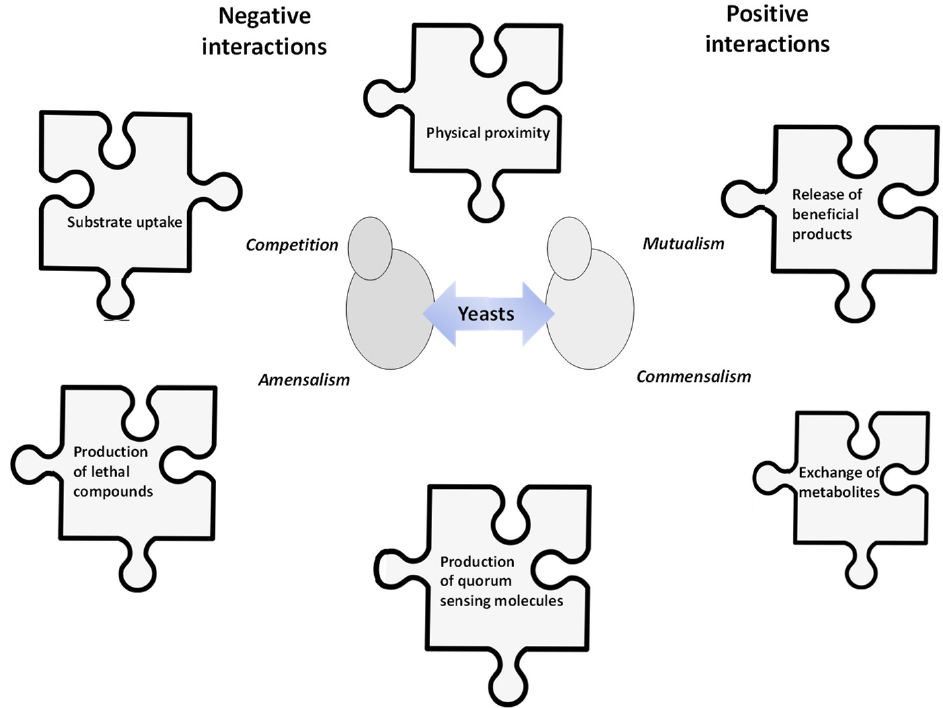
Figure 1. The puzzle of wine yeast interactions . Table 1. Type and mode of inter- and intra-species yeast interactions in wine.